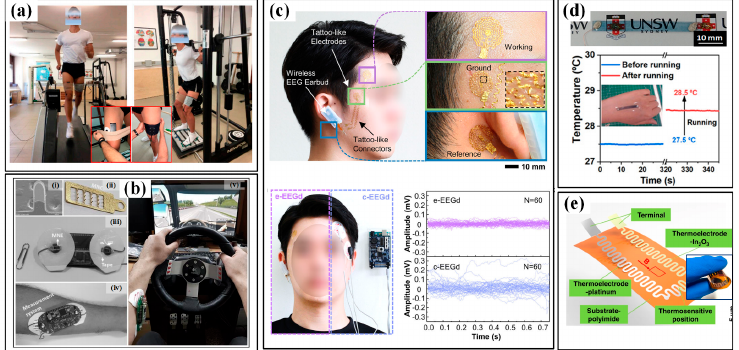
Figure 14. The EMG, EEG and temperature sensors for sport monitoring: ( a ) the EMG sensor to monitor the strength and endurance exercises in vivo [150]; ( b ) the microneedle array electrode-based wearable EMG system to detect the driver drowsiness. (i) is the SEM photo of one single needle; (ii) is the photo of the microneedle array electrode; (iii) is the wearable EMG system; (iv,v) are the system worn on forearm and driving [151]; ( c ) the earbud-like wireless EEG device (up) show a good ability in decreasing direct noise (down) [152]; ( d ) the wearable temperature sensor (up) and the measured small rise of skin temperature before and after a 5-min running exercise (down) [153]; ( e ) thin thermocouples film [39]. Reproduced with permissions from American Chemical Society (2020)